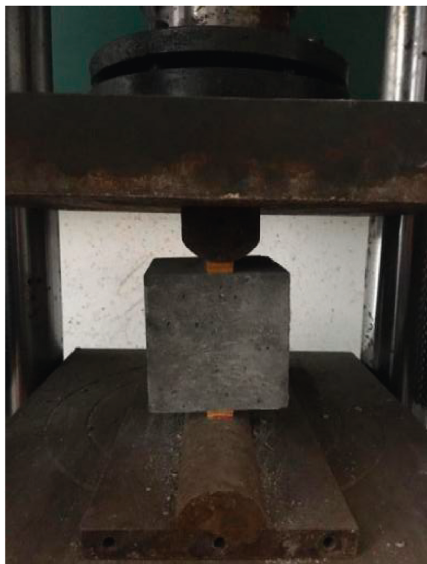
Figure 4: Splitting tests.